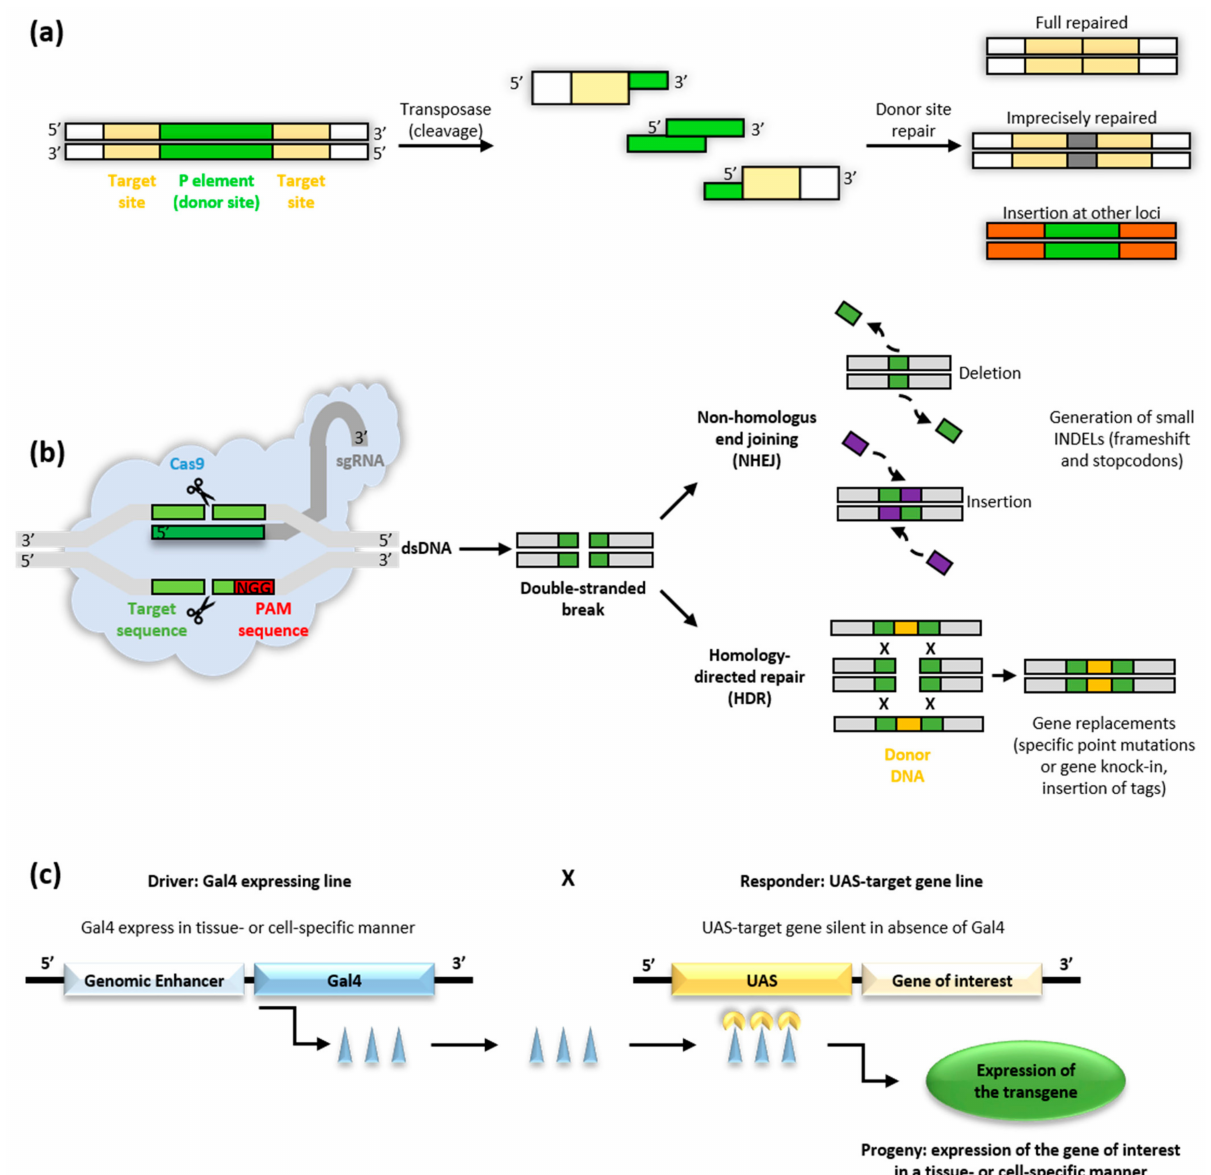
Figure 5. Approaches to model diseases in Drosophila . Schematic view of the principal genetic approaches adopted to manipulate the Drosophila genome in a reverse approach. ( a ) P-element excision can generate a deletion or a mutation, can exit leaving the region fully intact or produce insertion in other sites. ( b ) The combination of the bacterial endonuclease Cas9 with a small guide RNA (gRNA) can drive the Cas9 to a genomic target site 5 (cid:48) to an NGG protospacer adjacent motif (PAM). Repair of CRISPR/Cas9-mediated DNA double-strand breaks can occur by error-prone non-homologous end joining (NHEJ) or by homology-directed repair (HDR). ( c ) The UAS-GAL4 binary system allows the expression of the desired construct under the control of GAL4 protein. The system combined two transgenic lines, the driver line carrying the GAL4 expressed under a genomic enhancer and the responder line carrying the UAS promoter upstream of a gene of